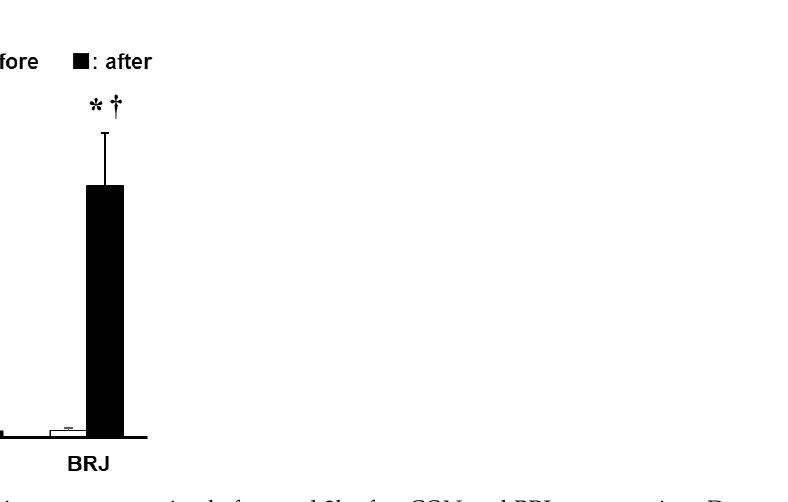
Figure 1. Plasma nitrate concentration before and 2h after CON and BRJ consumption. Data are shown as the mean ± standard deviation. CON: NO 3 − -depleted prune juice; BRJ: beetroot juice. * p < 0.05, significant difference between before and after. † p < 0.05, significant difference between CON and BRJ. Data are expressed as values for n = 16 (10 men and 6 women). Table 1. Changes in circulatory parameters and venous volume in non-exercising limbs with static handgrip exercise in CON and BRJ. Pre-Exercise